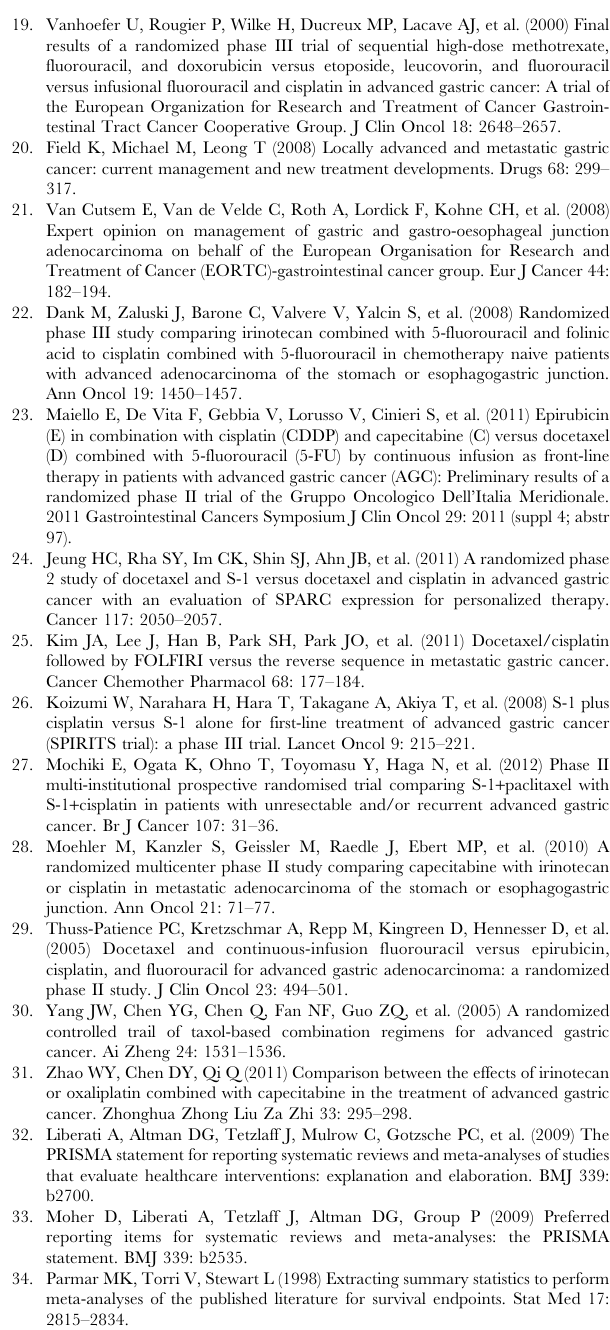
Figure S1 Assesing risk of bias for all eligible random- ized controlled trials. Table S1 Trails comparing platinum-based regimens with non-platinum-based